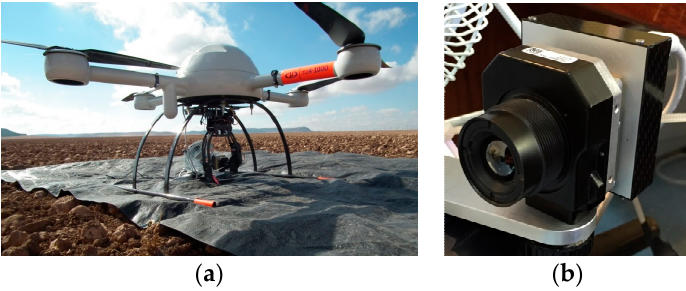
Figure 1. Unmanned aerial vehicle, Microdrone MD4-1000 ( a ) and uncooled thermal camera ( b ).